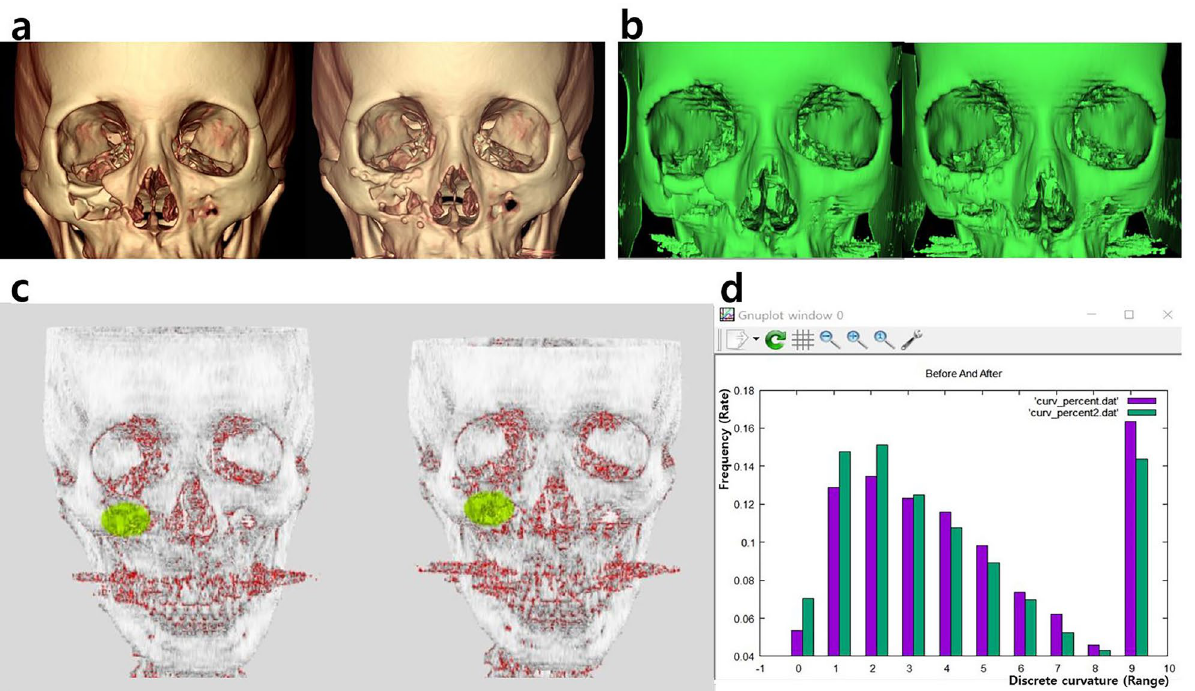
Figure 2. Analysis of the anterior maxilla. ( a ) Fractured right anterior maxilla was noted preoperatively and the segment was reduced postoperatively. ( b ) The initial DICOM imaged were converted in to OBJ files. ( c ) The subject areas were selected and displayed in fluorescent green. ( d ) The discrete curvature mainly showed large values preoperatively (purple bars), and the range shifted toward smaller values postoperatively (green bars). The range of large values-high curvature (from 4 to 9) was more dominant preoperatively, and the range of small values-low curvature (from 0 to 3) postoperatively. The weighted average of curvature changed from 0.58 to